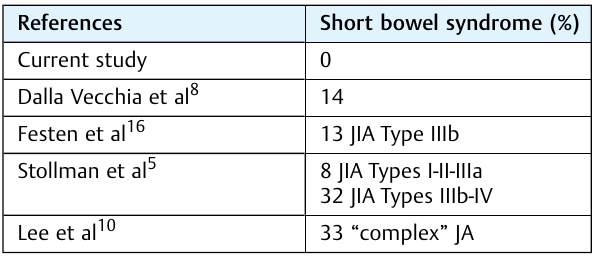
Table 3 Short bowel syndrome rate of current and different studies published in the